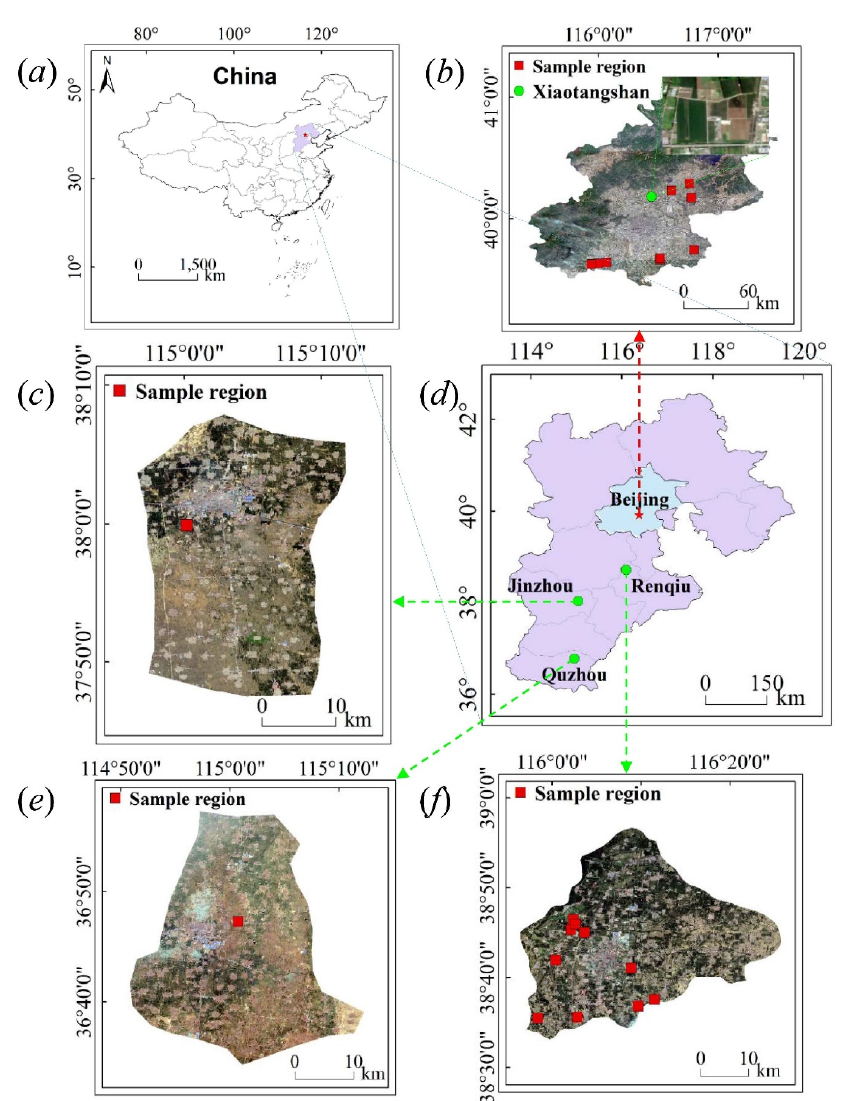
Figure 1. Location of study area: ( a ) China; ( b ) Beijing ang Xiaotangshan; ( c ) Jinzhou; ( d ) Hebei and Beijing; ( e ) Quzhou; ( f ) Renqiu.